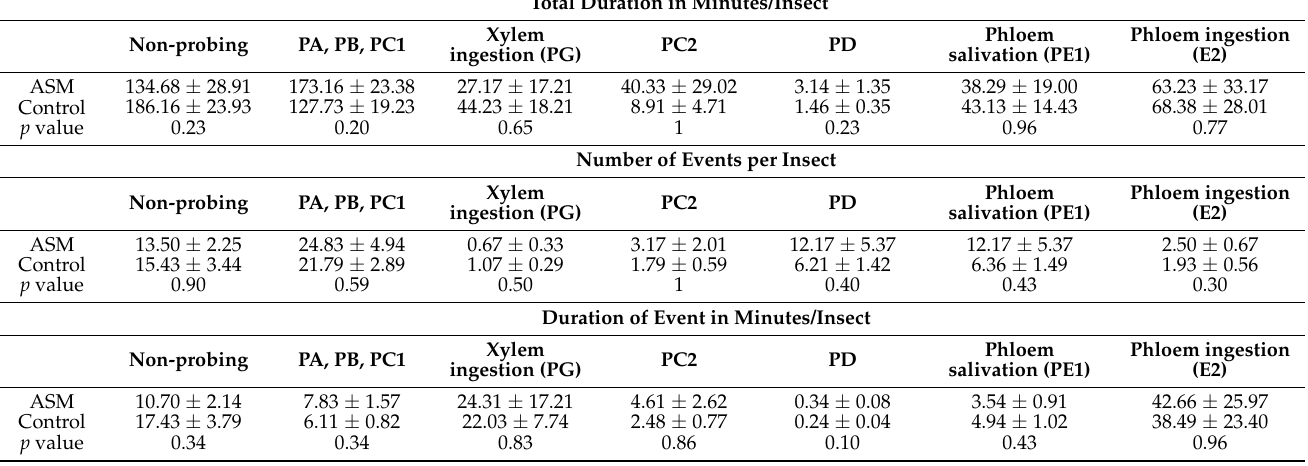
Table 3. Comparison of EPG-DC waveforms (mean time in minutes ± standard error of the mean, SEM, or mean number of events ± SEM) (8 h of recording) of C. pyri summer adults ( n = 16 on ASM, n = 14 control) feeding on ASM- or water- (control) treated pear plants. Waveforms were classified according to